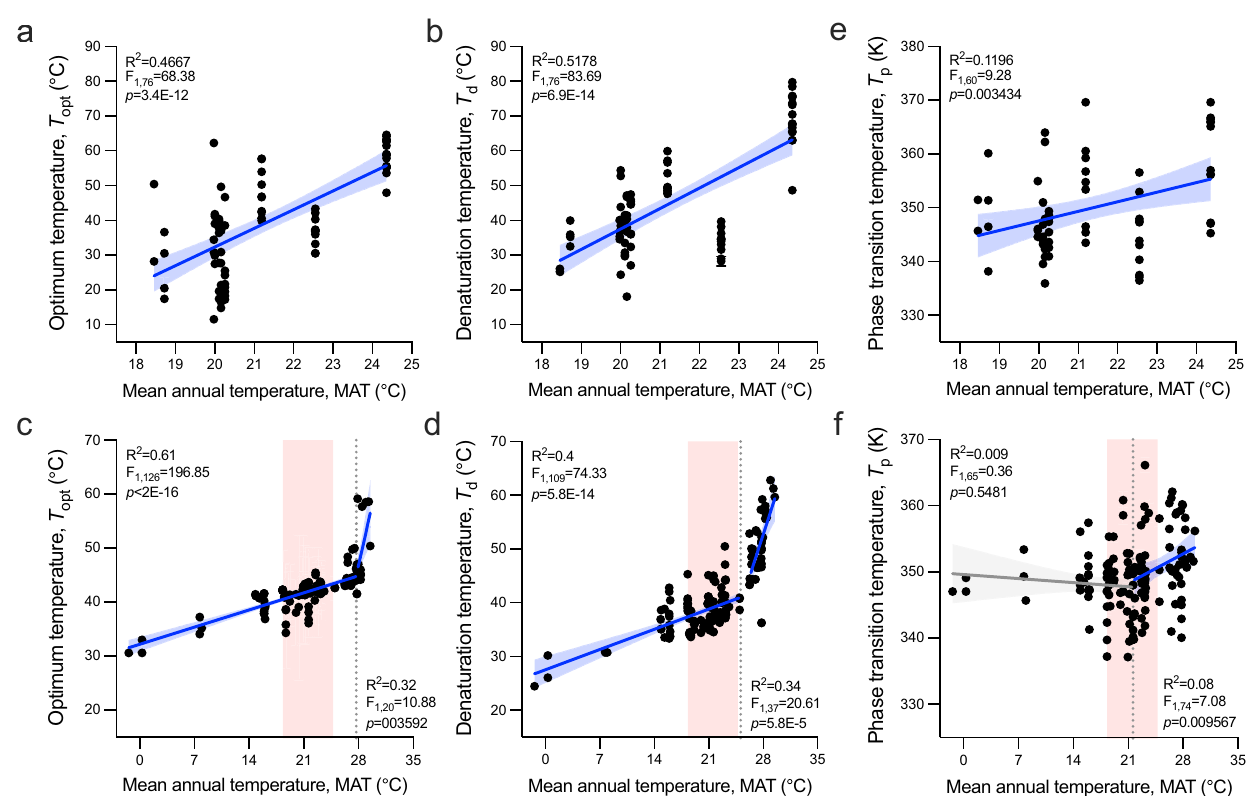
Fig. 2 | Thermal adaptation of puri fi ed isozymes from seawater